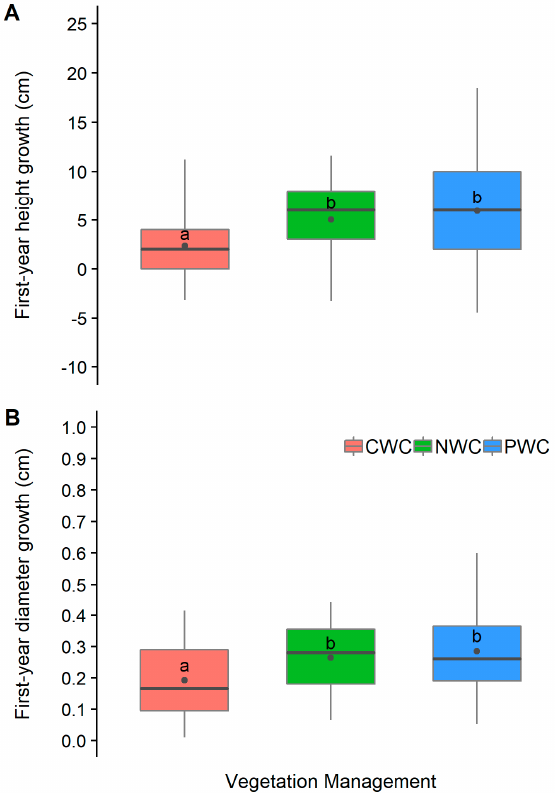
Figure 5. First-year height ( A ) and groundline diameter ( B ) growth of dormant season planted ponderosa pine in the Davis Mountains. Boxplots denote interquartile range, whiskers denote the 2.5th and 97.5th percentiles, white horizontal line denotes the median, and black points denote the mean for each treatment. Treatments that share letters were not statistically different.